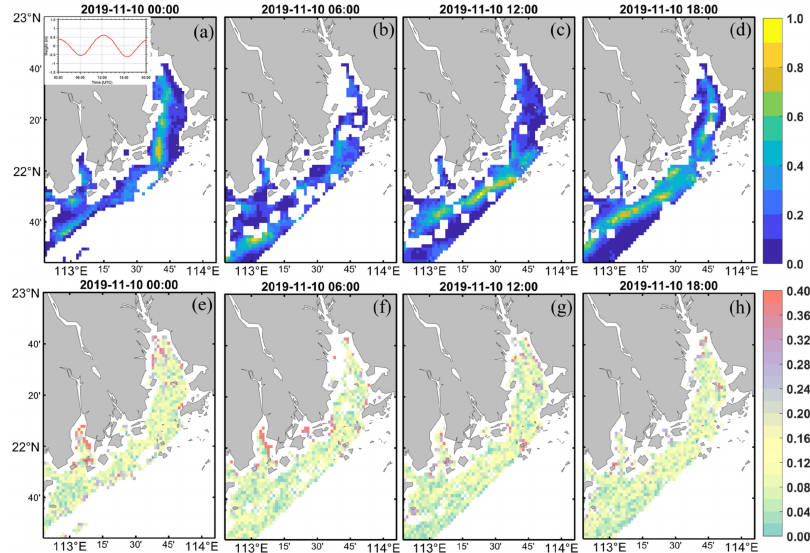
Figure 6. Same as Figure 5, but for 10 November